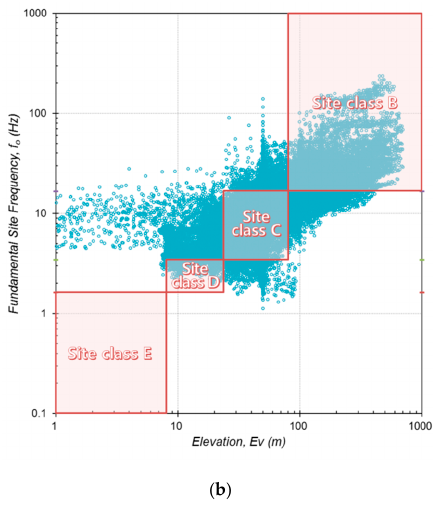
Figure 8. Geo-proxy-based empirical preliminary classification for each site classification condition according to f 0 ( T G ) in Seoul: ( a ) surface terrain slope; ( b ) surface elevation. Table 4. Existing and proposed systems for site classification based on the proxy of surface slope.